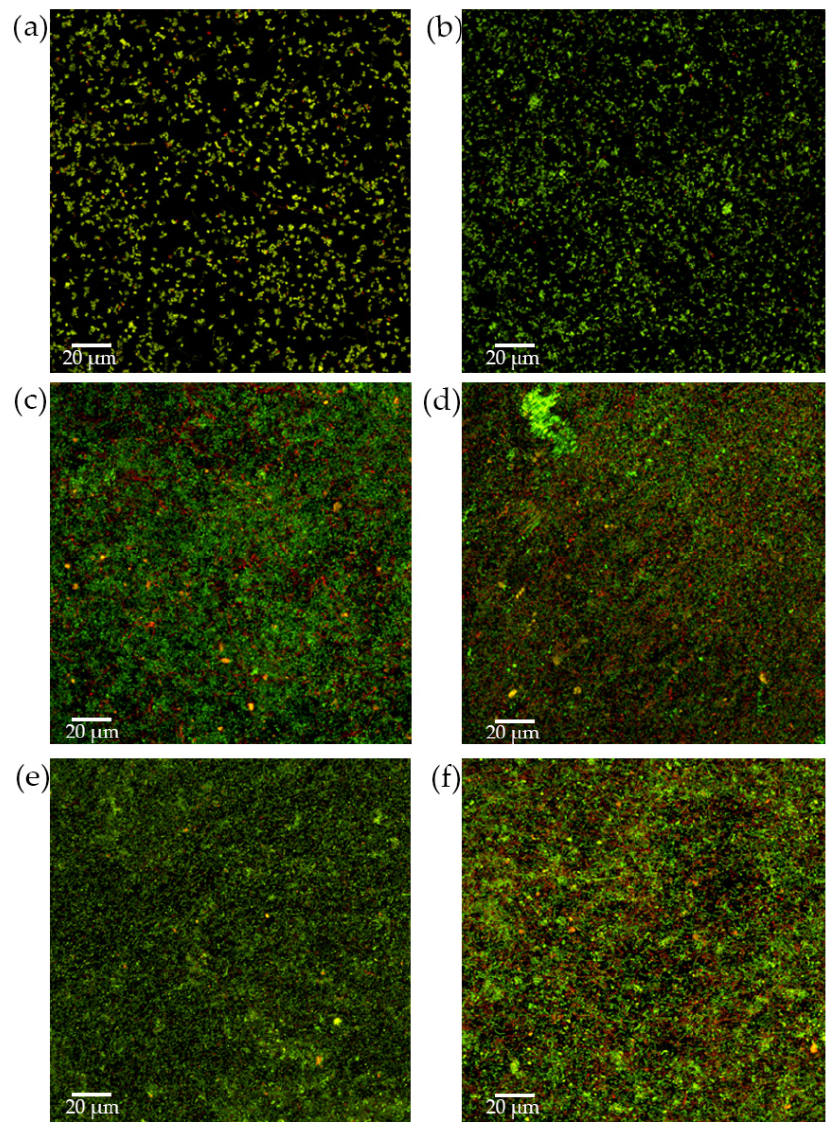
Figure 3. Confocal micrographs that represented a 2D maximum projection of the series along fixed axis of the control biofilms ( a , c , e ), composed by Streptococcus mutans, Veillonella parvula, Actinomyces naeslundii, Fusobacterium nucleatum, Aggregatibacter actinomycetemcomitans, and Porphyromonas gingivalis , and experimental biofilms, incorporating also Streptococcus downii sp. nov. ( b , d , f ), after 24 h ( a , b ), 72 h ( c , d ) and 120 h ( e , f ) of growth. LIVE/DEAD ® BacLight TM Bacterial Viability Kit stain was used to assess the vitality of cells (live cells in green and dead cells in red color; yellowish corresponded to damage cells but still alive).